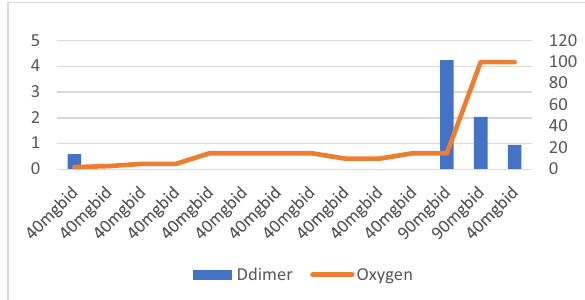
Figure 9: Patient number 9 presented at an early stage requiring nasal canula oxygen and D - dimer level was also low on presenta - tion. The D - dimer levels are missing during the hospital stay except on admission and at the end. But the fi gure shows that the D - dimer increased signi fi cantly prior to intubation; however, it was possibly a missed opportunity as D - dimer was not checked in the interim. The patient was treated with intermediate dose of Enoxaparin ( 40 mg SubQ BID ) since the admission and adjusted to full dose of Enoxaparin ( 90 mg SUBQ BID ) when patient was intubated. This patent subsequently died due to COVID -